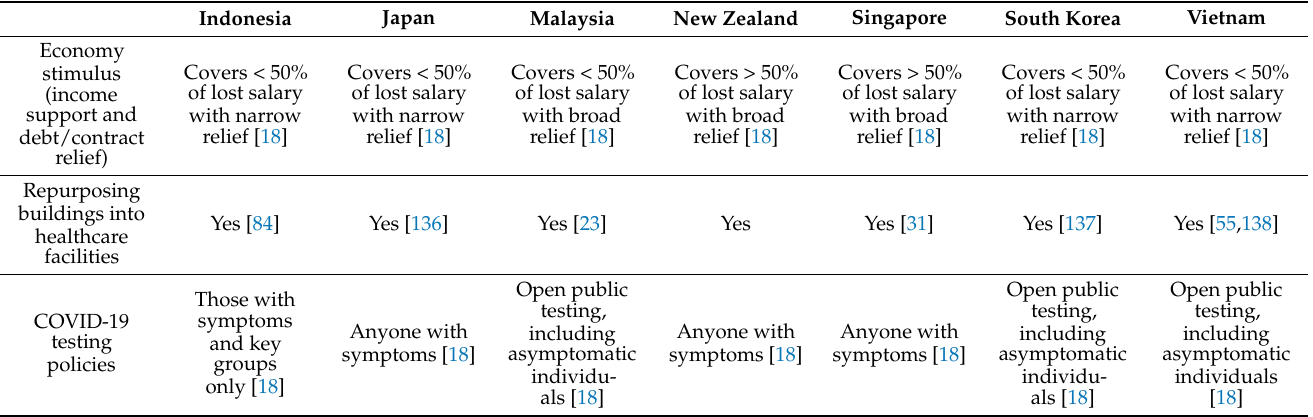
Table 15. Countries’ emergency response plans and COVID-19 testing